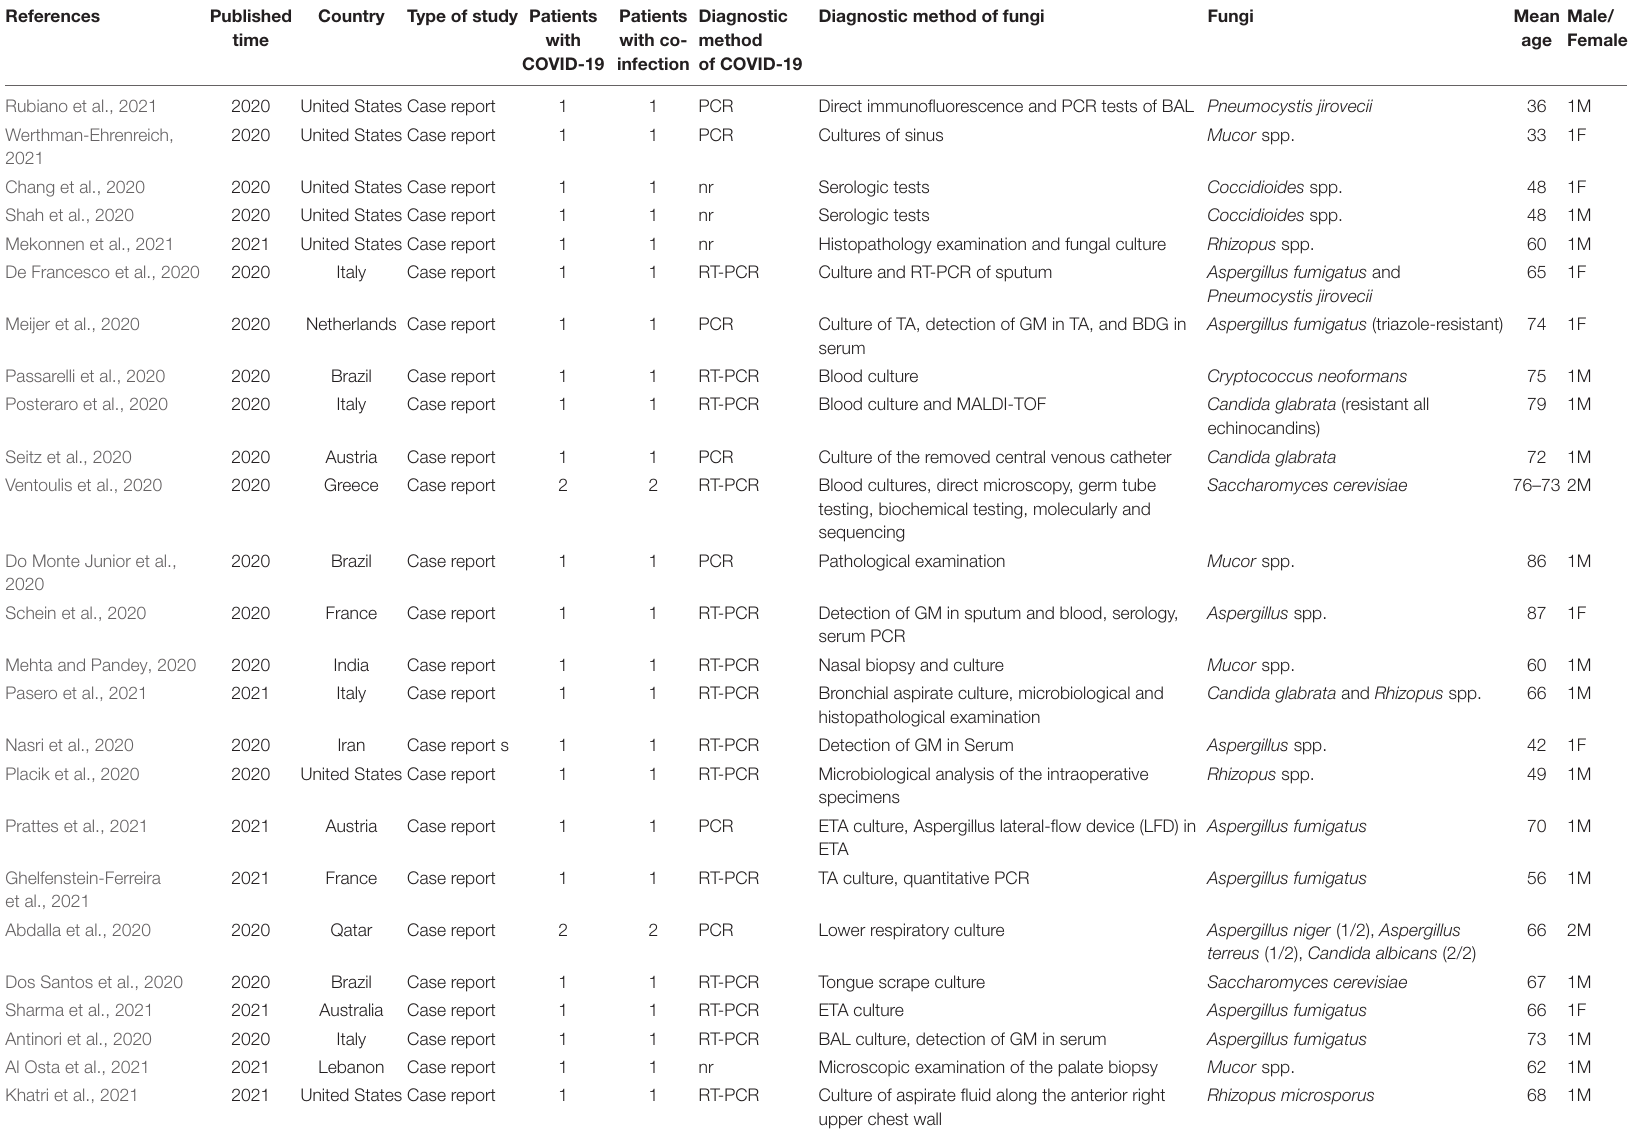
TABLE 1 | Characteristics of included prevalence